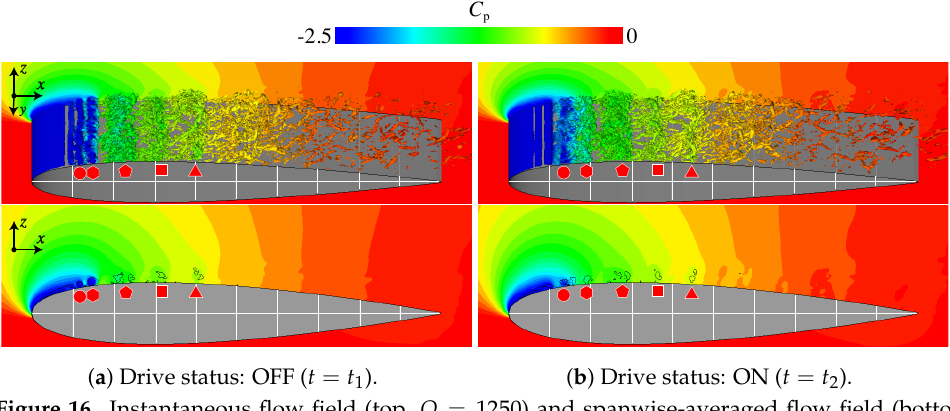
Figure 16. Instantaneous flow field (top, Q = 1250) and spanwise-averaged flow field (bottom, Q = 250) with isosurfaces of the second invariant of the velocity gradient tensor ( Q ) colored based on C p in the DTM at α = 12. The red symbols denote the locations of representative spanwise vortices.